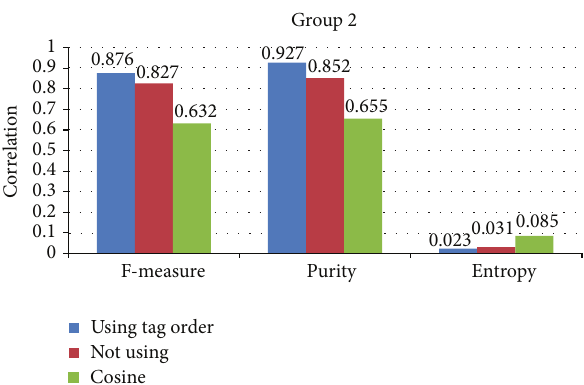
Figure 7: The clustering results of group 2 data